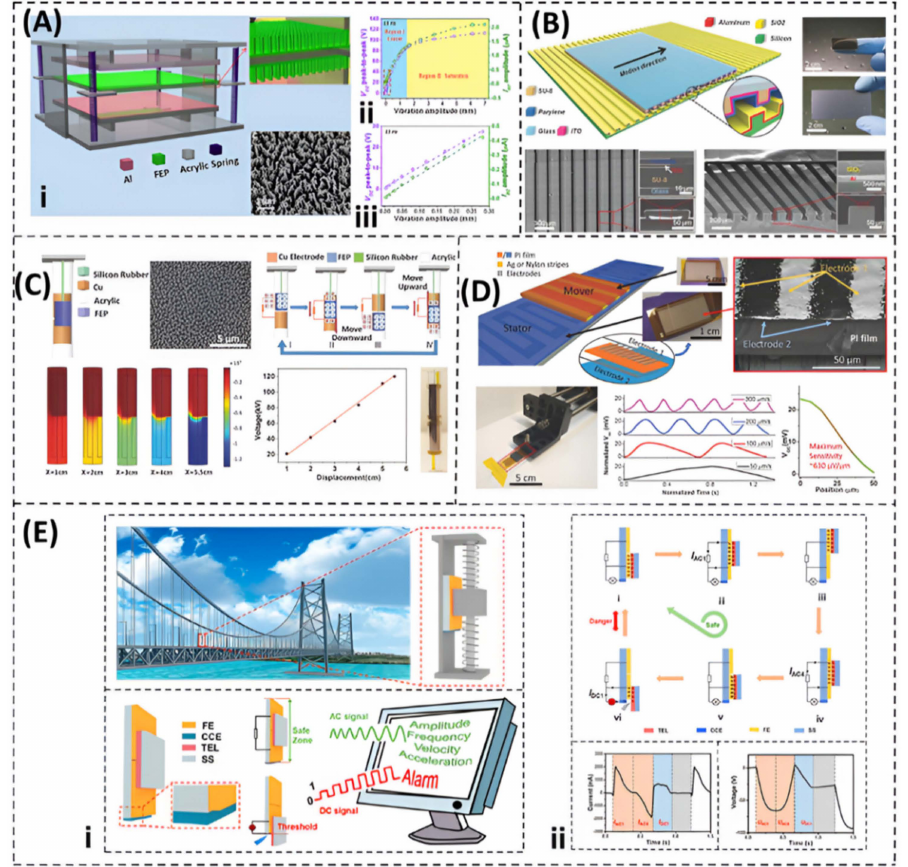
Figure 5. Triboelectric sensors for vibration-displacement measurements. ( A ) A contact-separation- enabled freestanding TENG sensor for measuring vibration displacement amplitude, (Reprinted with permission [80], copyright 2014, American Chemical Society). ( B ) A single dimensional dis- placement and speed sensor technology based on two layers of micro-grated triboelectric layers (Reprinted with permission [81], copyright 2013, John Wiley and Sons). ( C ) An integrated self- powered dynamic displacement monitoring system for structural health monitoring (Reprinted with permission [82], copyright 2017, John Wiley and Sons). ( D ) An aerosol jet printing (AJP) that is used to create triboelectric sensors from different materials, including polymers, which may be directly printed into finely detailed grating structures for increased sensitivity to displacement and speed of motion (Reprinted with permission [83], copyright 2018, John Wiley and Sons). ( E ) A self-powered vibration sensing system that can detect vibration properties in real time, continuously using a dual-mode triboelectric nanogenerator that can create either alternating current (AC) or direct current (DC) within various operation zones (Reprinted with permission [84], copyright 2020, American Chemical